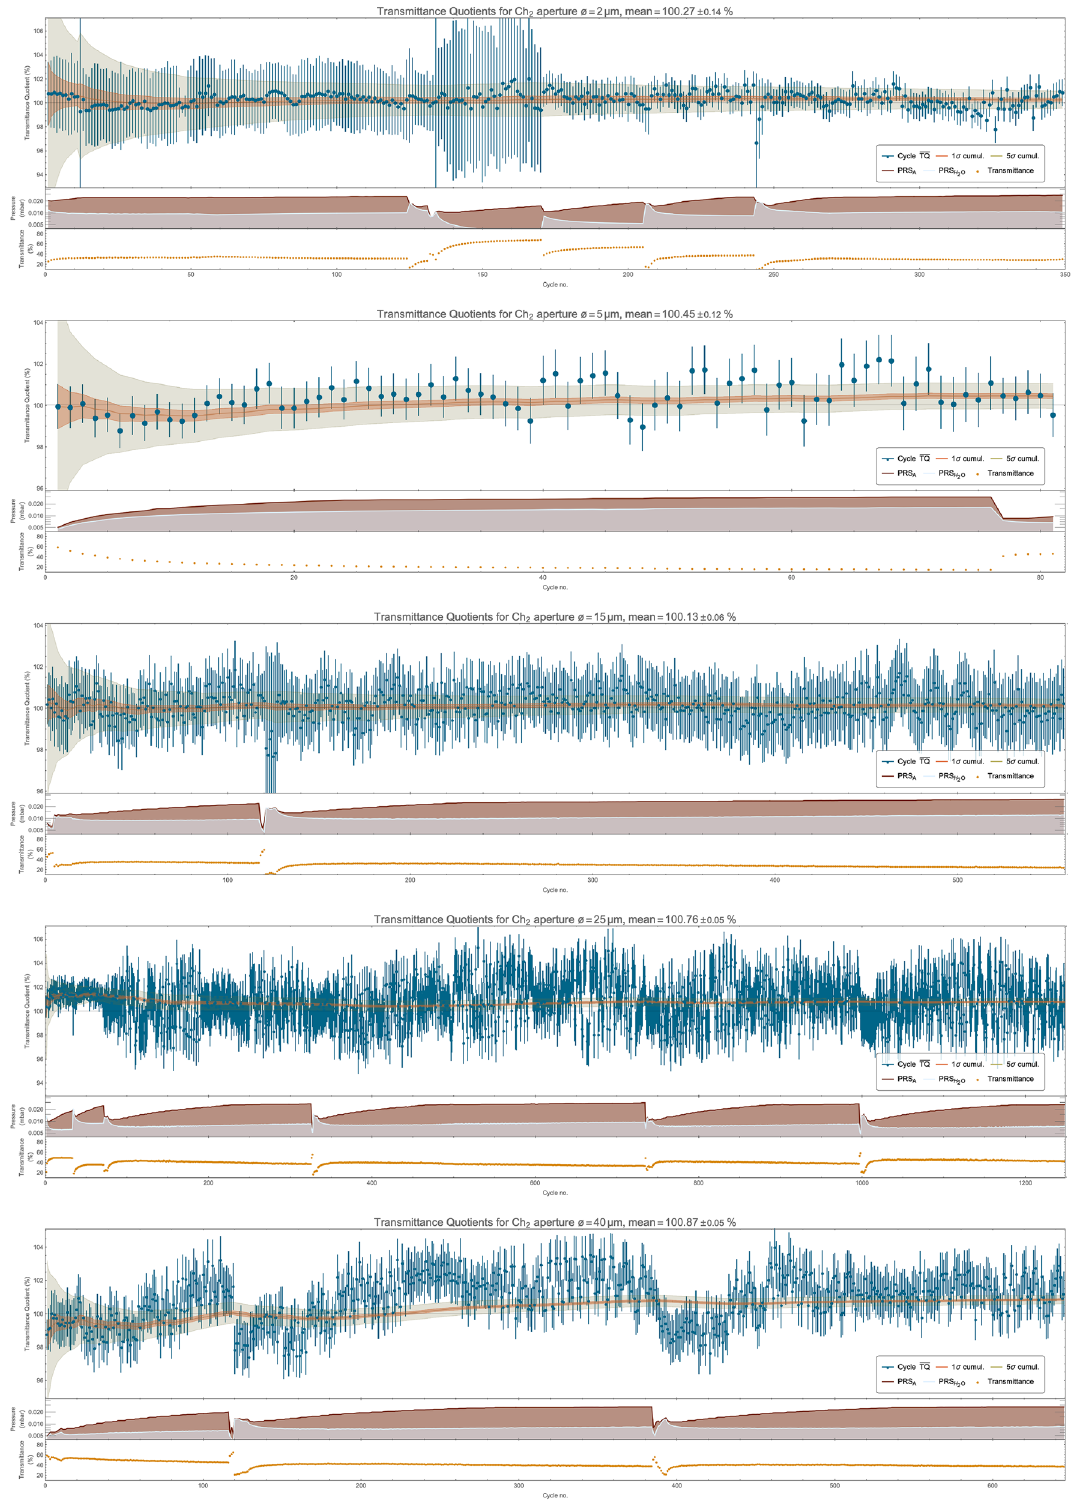
Figure 9. Mean transmittance quotients along with their 1 σ standard errors for the individual cycles and the bands showing the accumulated 1 σ and 5 σ measurement uncertainties, both total & partial pressures and transmittance readings are